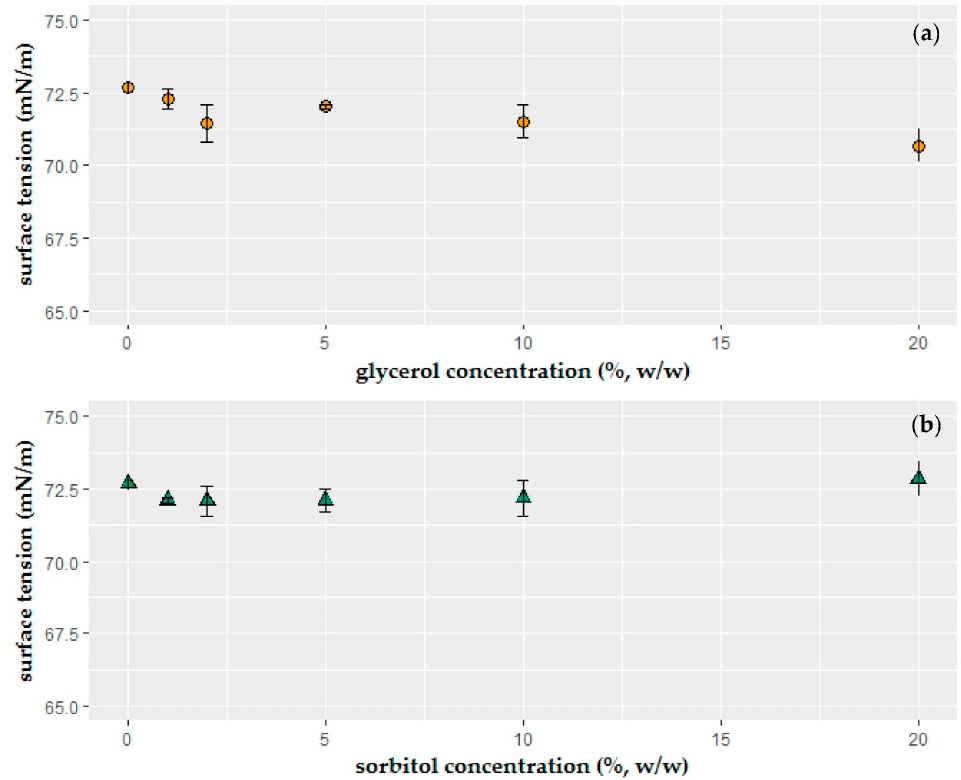
Figure 2. Effect of plasticizer ( a ) glycerol, ( b ) sorbitol concentration (%, w / w ) on surface tension (mN/m) of the coating solution. Glycerol or sorbitol was incorporated into 1.25% ( w / w ) sodium alginate solutions ( n = 3).